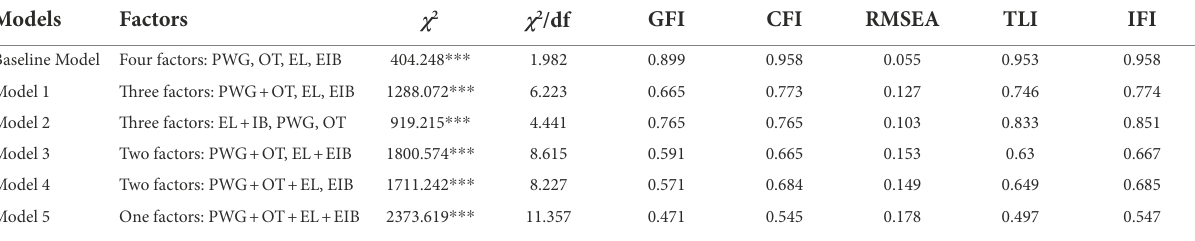
TABLE 2 Comparison of measurement